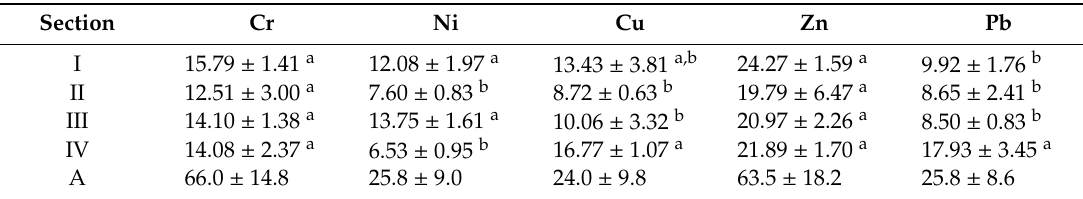
Table 3. Heavy metal levels of sediment from four sections and the average metal levels in the A horizon soil layer in Shandong Province, China. (mg / kg).